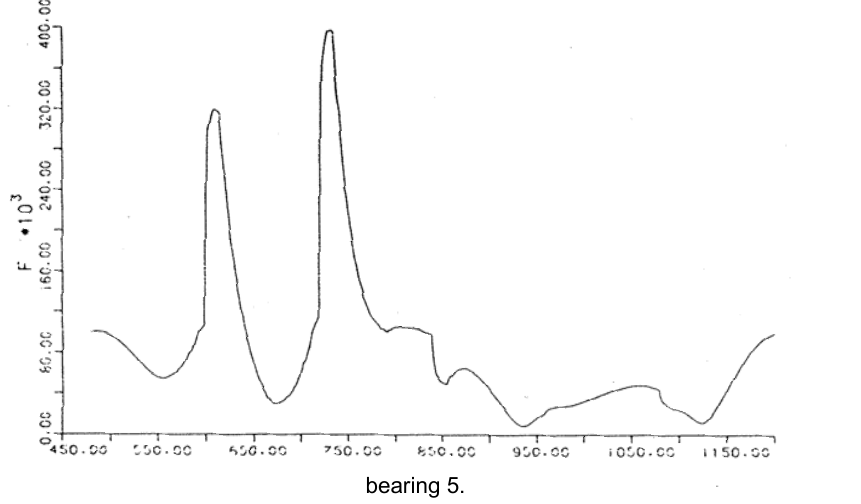
Figure 5 – Change of the angle ((  ) and the load intensity of the main sleeve of the 5th bearing depending on the angle of rotation of the engine crankshaft Рисунок 5 – Изменение угла ((  ) и интенсивности нагрузки главного рычага 5- го подшипника в зависимости от угла поворота коленчатого вала двигателя Слика 5 – Промена угла (  ) и интензитета оптерећења главног рукавца 5.